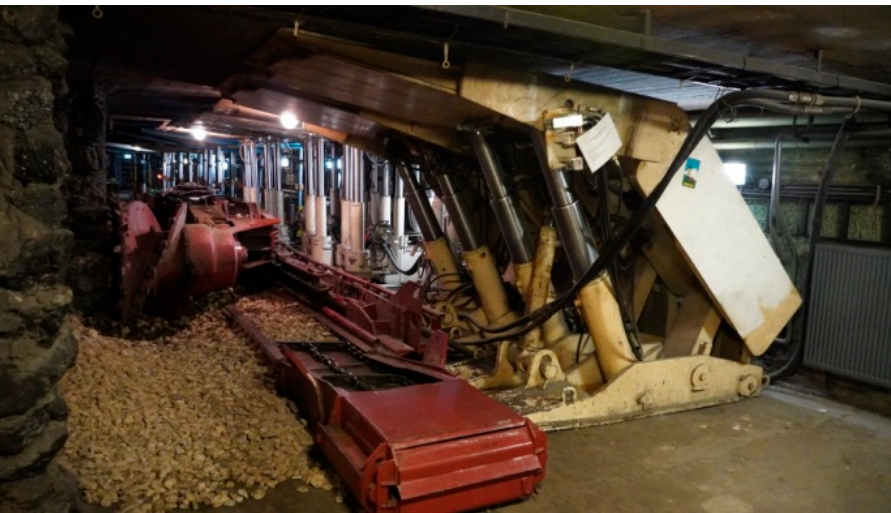
Figure 6. Photographic image of the mine corridor after accident.